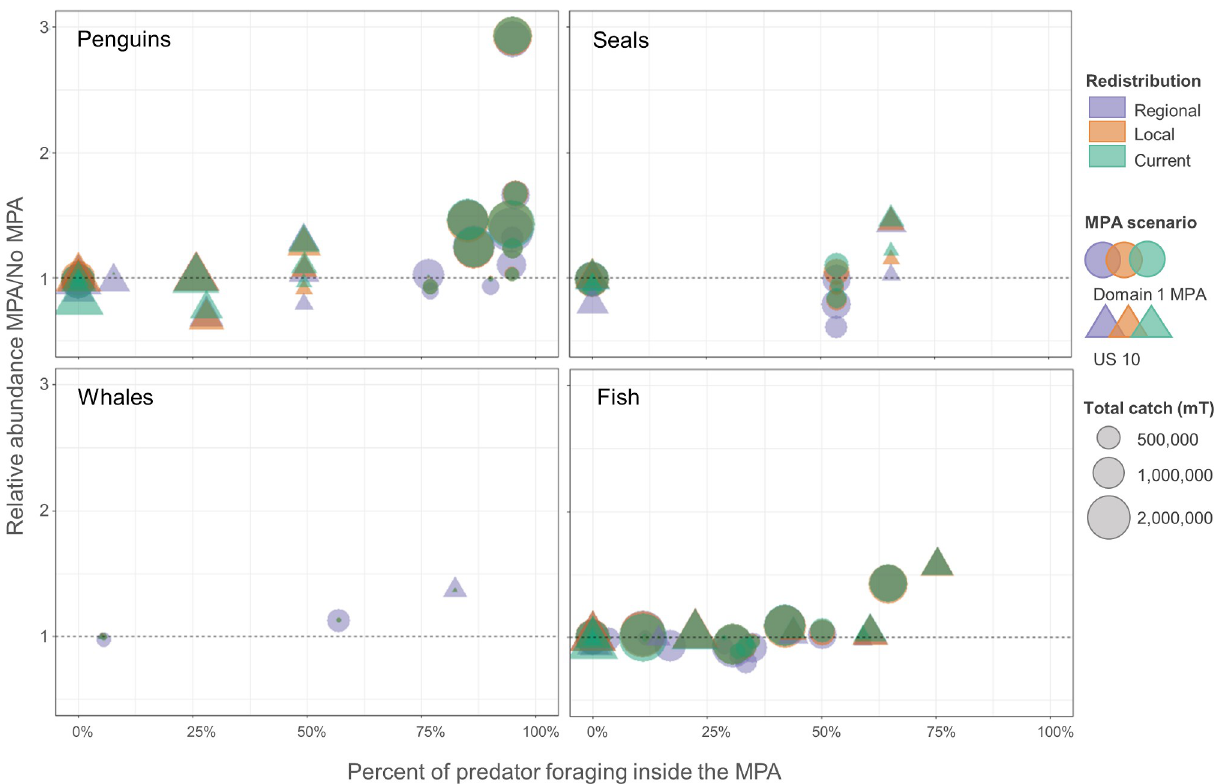
Fig 7. Relative abundances of species groups by SSMU given percentages of foraging inside an MPA. Relationship between the percent of foraging during summer (the breeding season) that occurs inside an MPA (x-axis) and change in abundance of each species group (penguins, seals, whales, and fish) relative to the No MPA reference (MPA/No MPA, y-axis). Each point represents an SSMU: circles are the D1MPA scenario and triangles US10. Colors denote redistribution alternative (Regional is purple, Local orange, and Current green). The dashed line at y = 1.0 indicates where there is no change in abundance with an MPA. Relative sizes of the points indicate the amount of catch in that SSMU; note many points overlap, indicating no difference across the redistribution alternatives for catches displaced by an MPA.